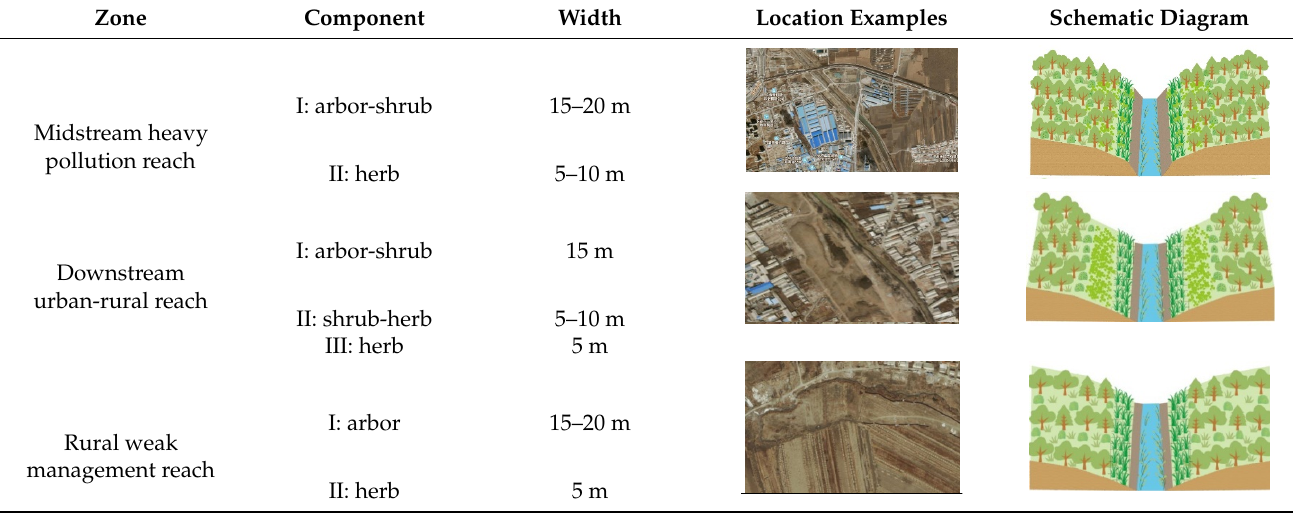
Table 6. The VBZ restoration design plan of DX river.